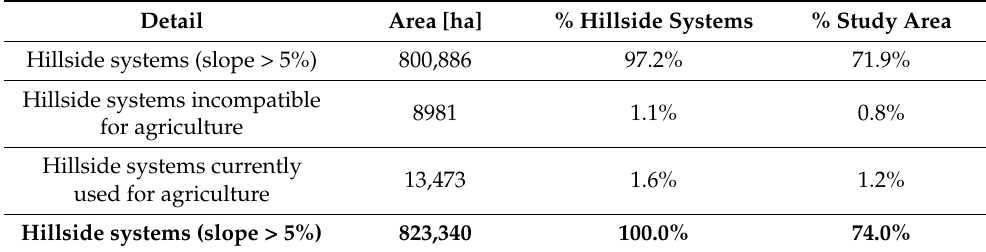
Table 4. Land uses in the hillside systems (Figure 4c).